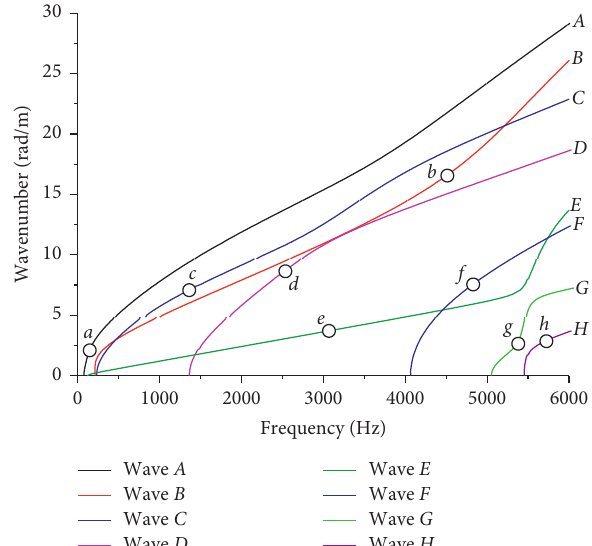
Figure 4: Dispersion curves of propagative waves in a periodically supported